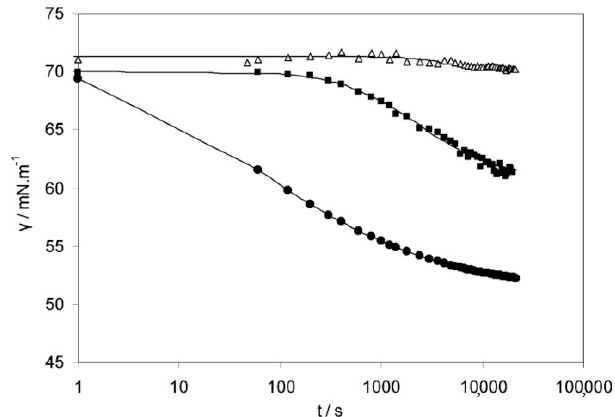
Figure 10. Dynamic surface tension of sodium hyaluronate solutions as a function of time: 2.0 mg/mL ( ∆ ), 2.8 mg/mL ( ■ ), 3.5 mg/mL ( ● ). Reproduced from [60], with permission from American Chemical Society, 2020.